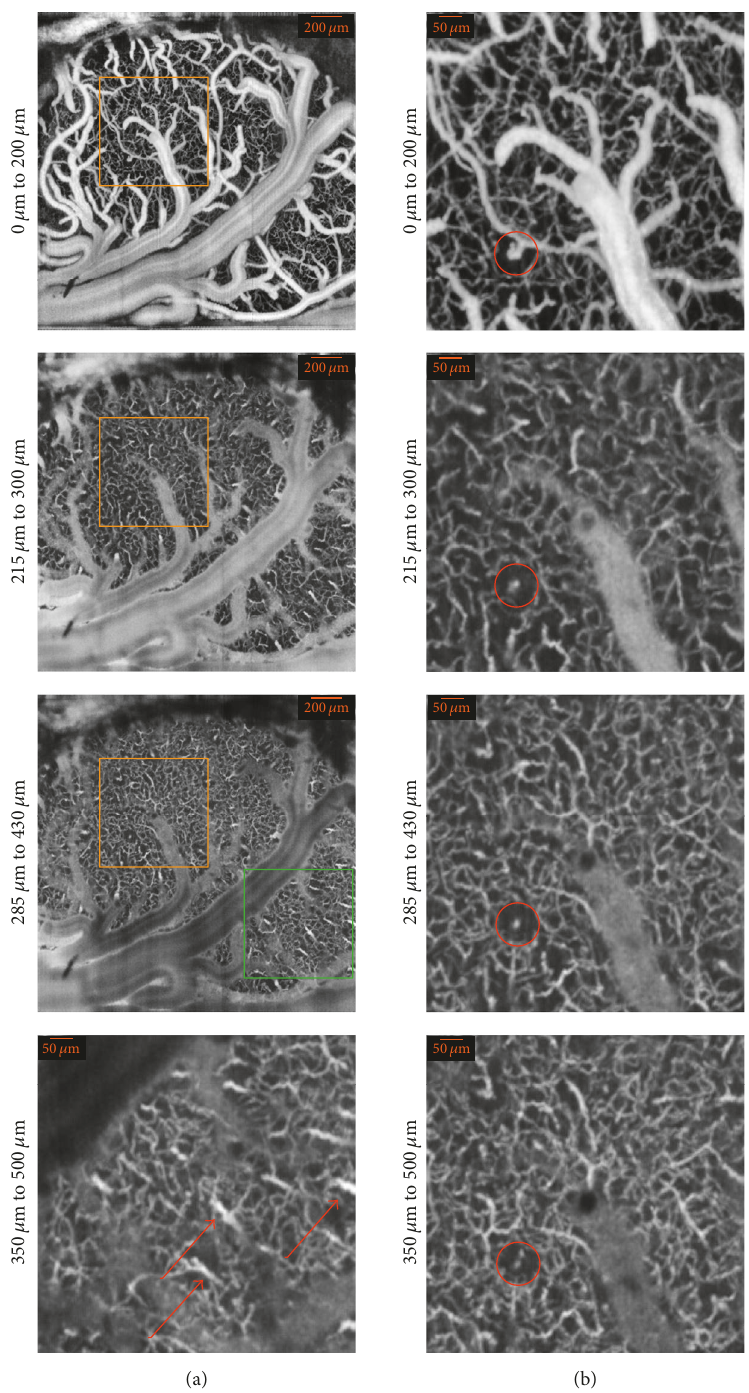
Figure 11: Imaging at various depths. By adjusting the position of the focal plane inside the brain, it is possible to analyze the topology and distribution of vascular networks at different depths in the brain. The red arrows mark some penetrating arterioles. The red circle on (b) depicts an arteriole that penetrates up to 500 𝜇 m deep in the brain before